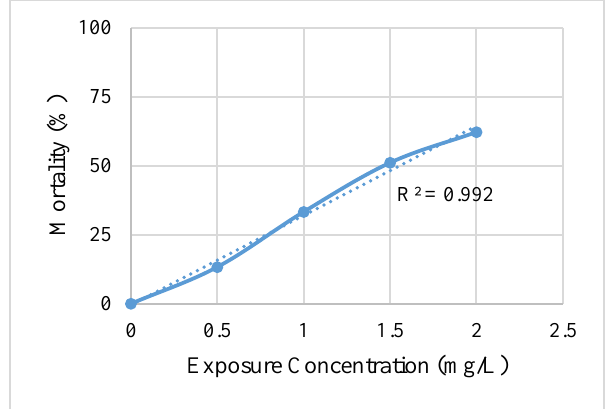
Figure 2. Mortality (%) of Tegillarca granosa after 72 h of exposure to a series of nitrite (NO 2 -N) concentrations.